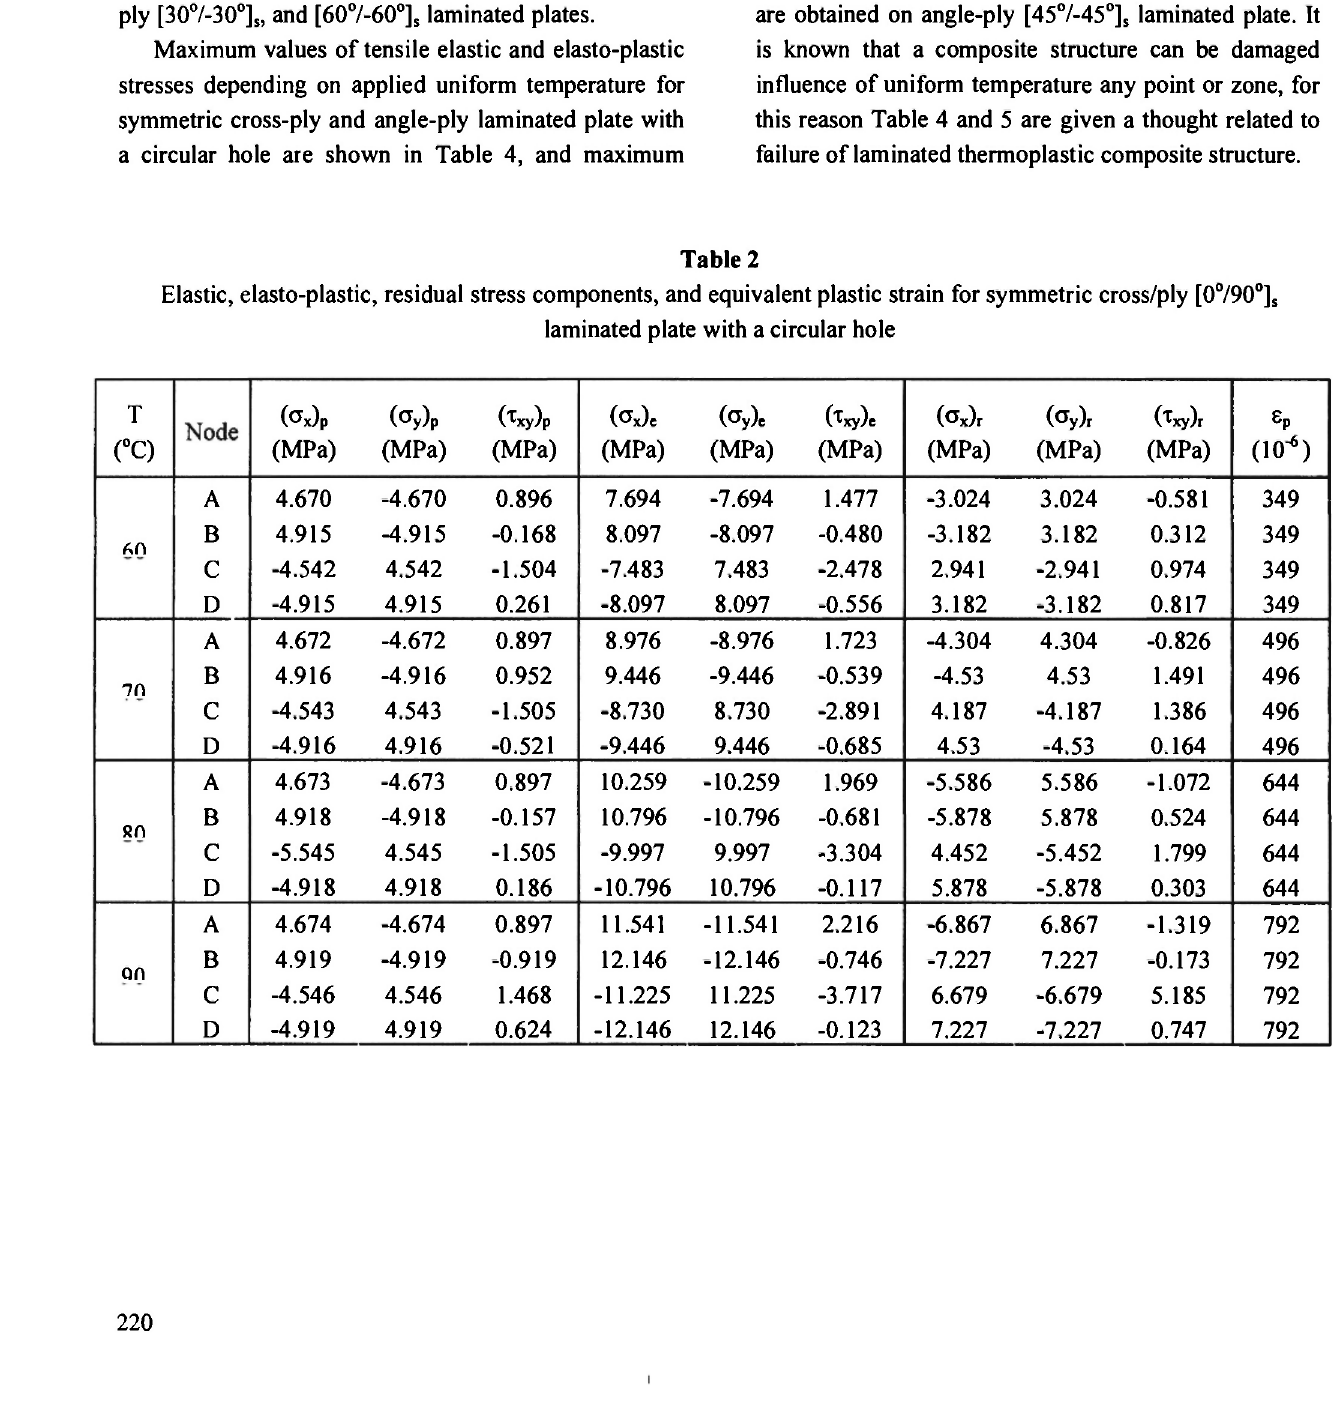
Elastic, elasto-plastic, residual stress components, and equivalent plastic strain for symmetric cross/ply [0°/90 o ]